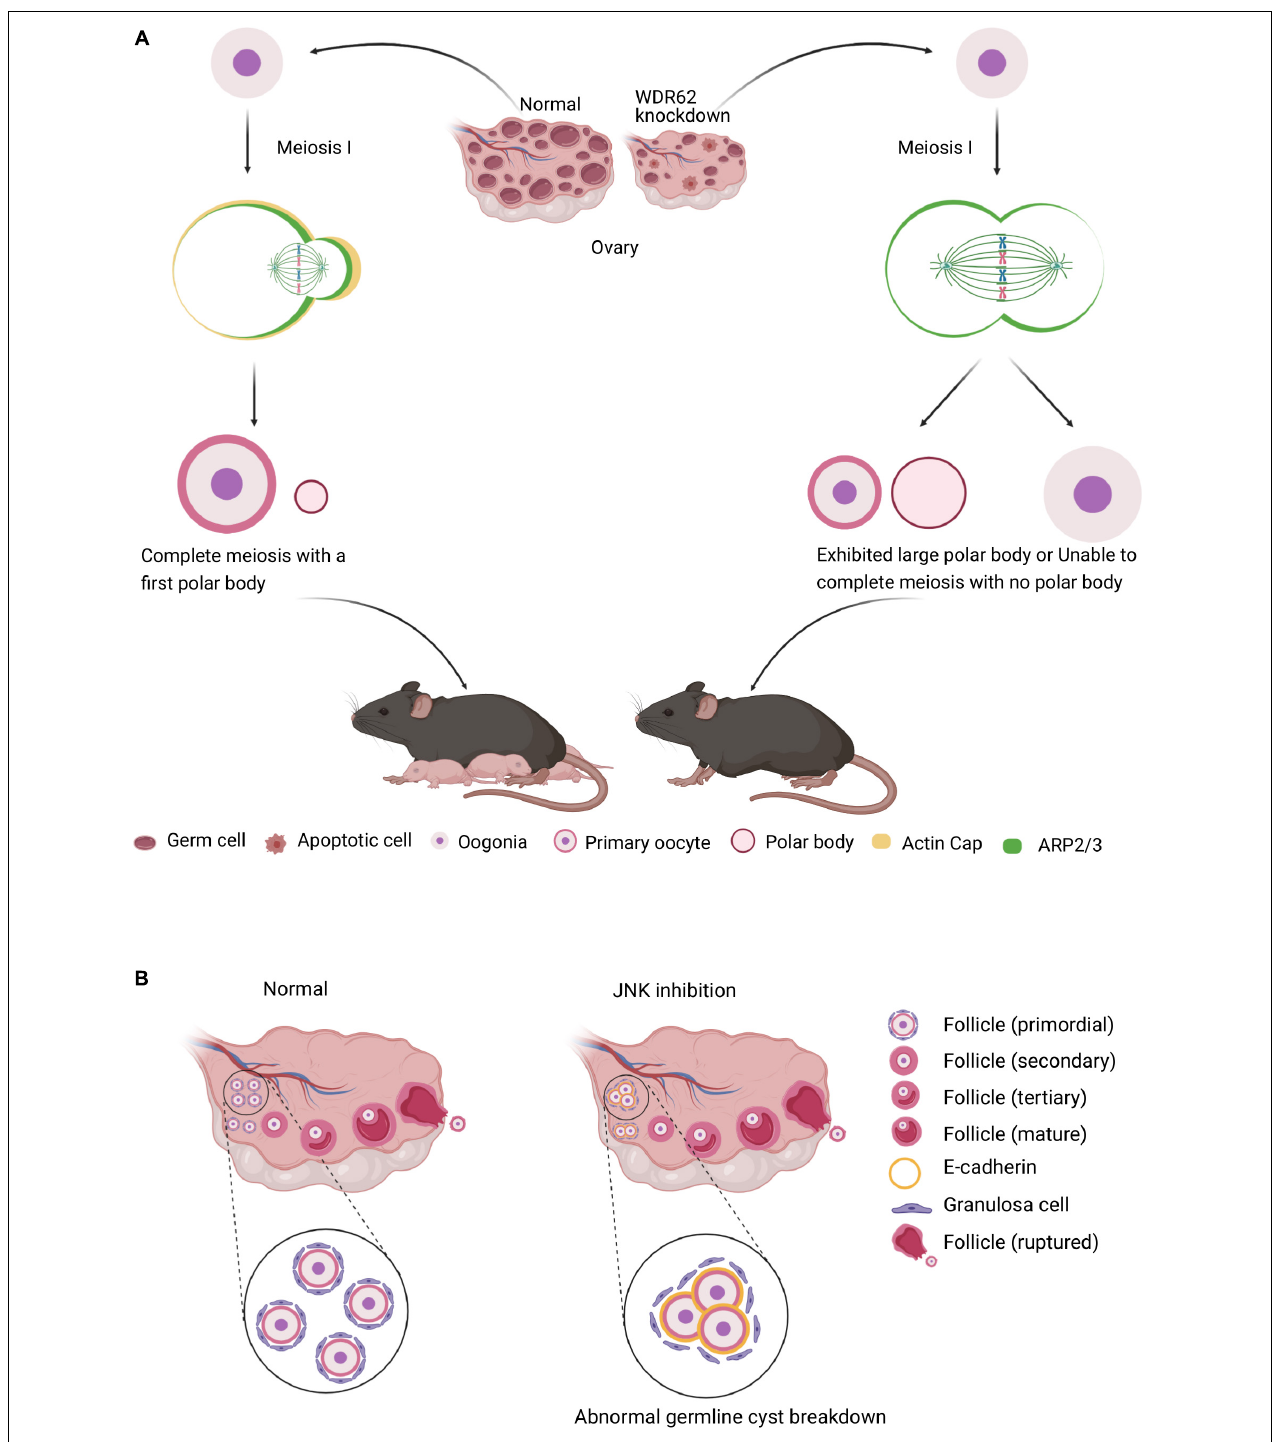
FIGURE 4 | WDR62 and JNK signaling in female meiosis. (A) In female meiosis, oocyte meiotic maturation is a form of asymmetric cell division, producing the first polar body and a large oocyte. The knockdown of WDR62 is associated with the apoptosis of germ cells, shrinking of the ovary and causing infertility, possibly by affecting spindle assembly and disrupting extrusion and asymmetric division of the first polar body. This process may require the modulation of ARP2/3 activation as well as the actin cap. (B) The JNK signaling is critical for germline cyst breakdown and primordial follicle formation. Disruption of the JNK signaling dramatically inhibits cyst rupture and primordial follicle formation in cultured mouse ovaries. In addition, E-cadherin is robustly expressed in germline cysts and its decline is required for oocyte release from cysts. However, inhibition of JNK signaling results in abnormally enhanced localization of E-cadherin adhesion protein at oocyte-ovarian contact sites and delays cyst